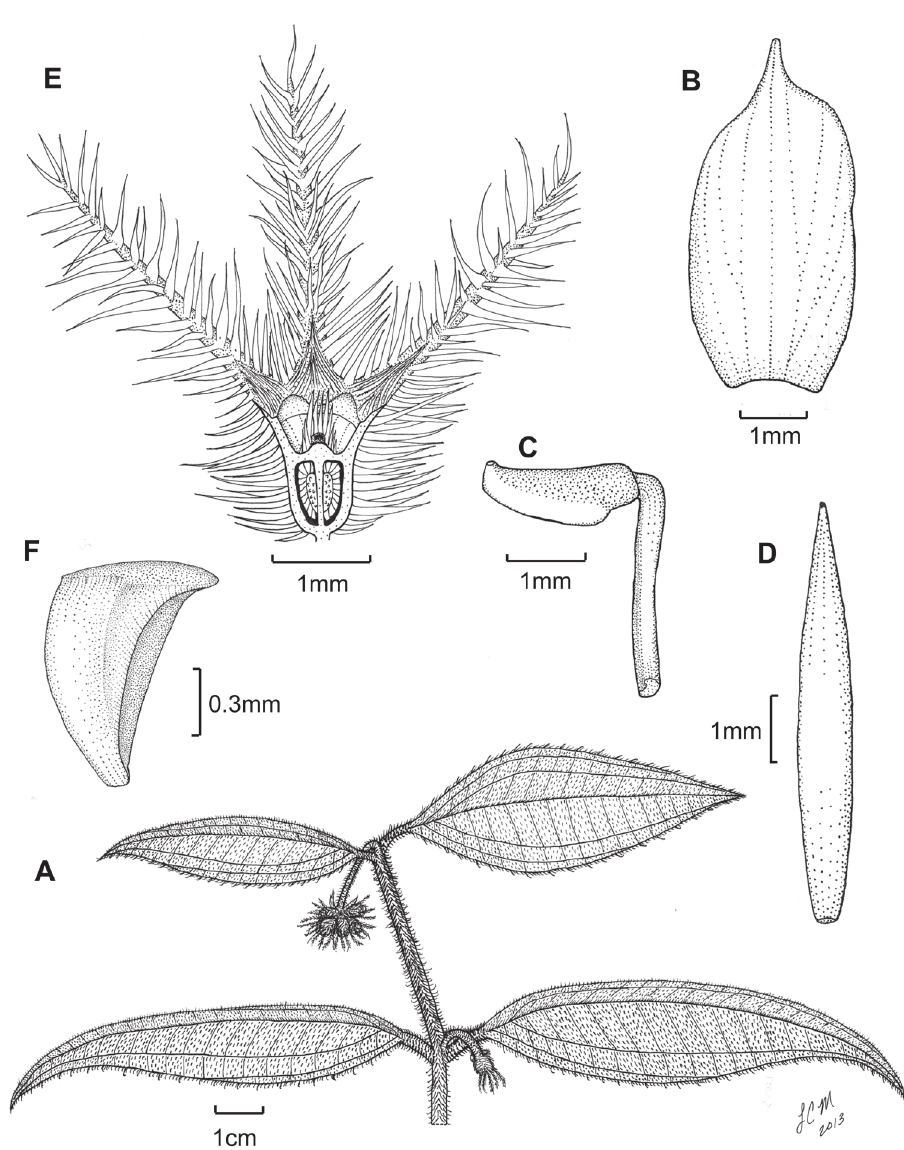
Figure 4. Illustration of Miconia jashaferi. A habit ( Ekman 3849 ) B petal ( Alain 871 ) C stamen ( Alain 871 ) D style ( Alain 871 ) e immature fruit longitudinal section ( Alain 871 ), seed ( Acuña SV-13275